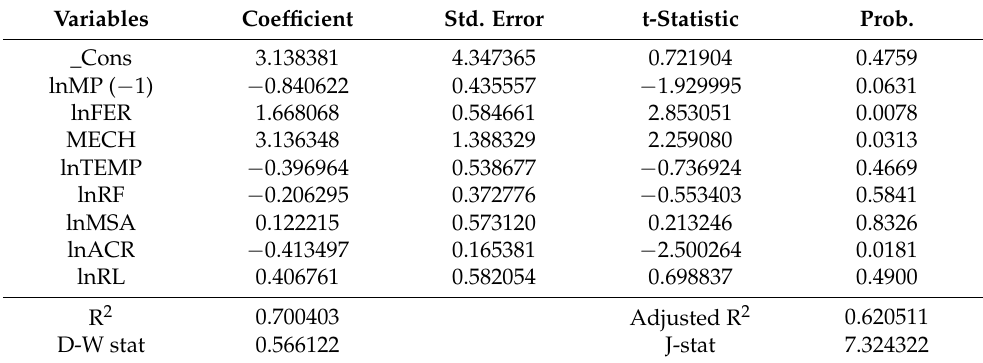
Table 6. The impact of technical progress and climate change on corn production (Model 3).